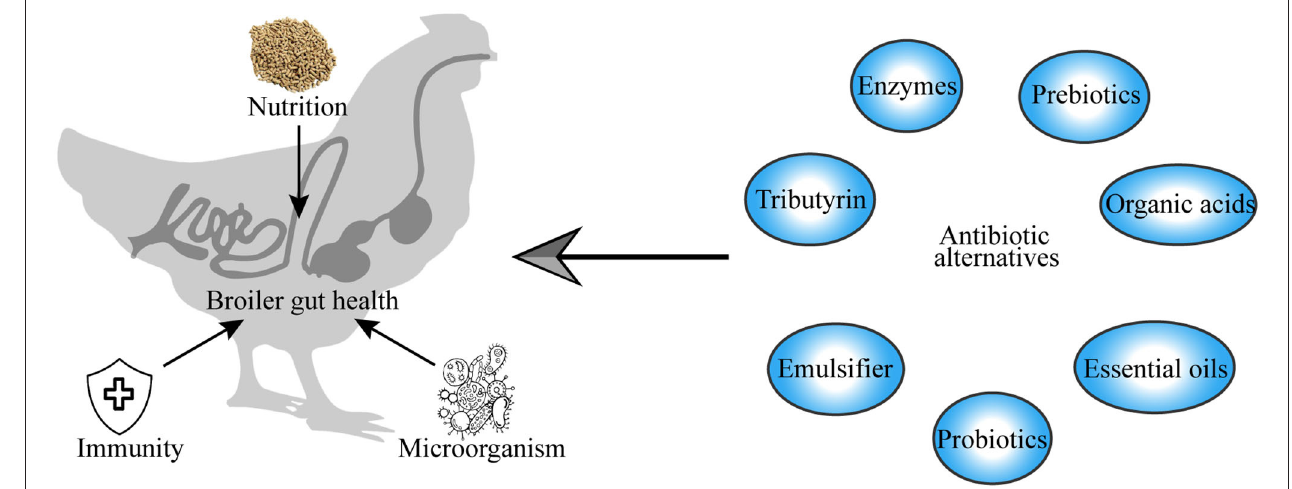
FIGURE 1 | Graphical